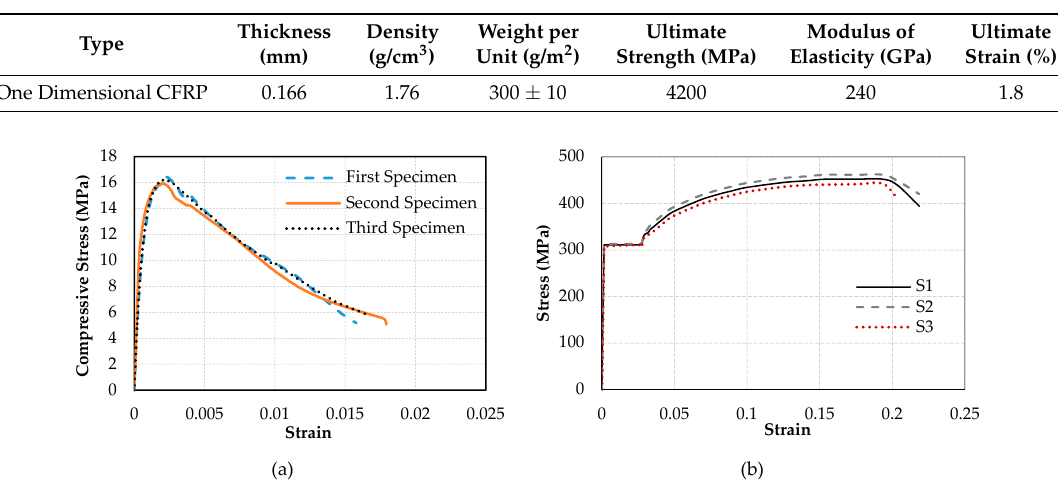
Table 2. Characteristics of carbon fiber-reinforced polymer (CFRP) sheets (as indicated by the manufacturer).